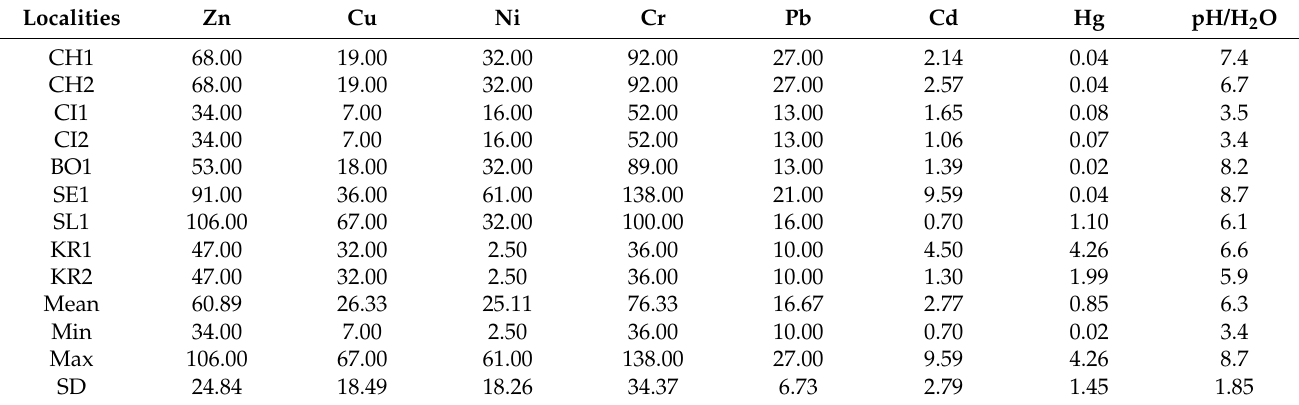
Table 1. Background values of risk elements (mg/kg) of the investigated localities for the soils of the Slovak Republic [50] and pH/H 2